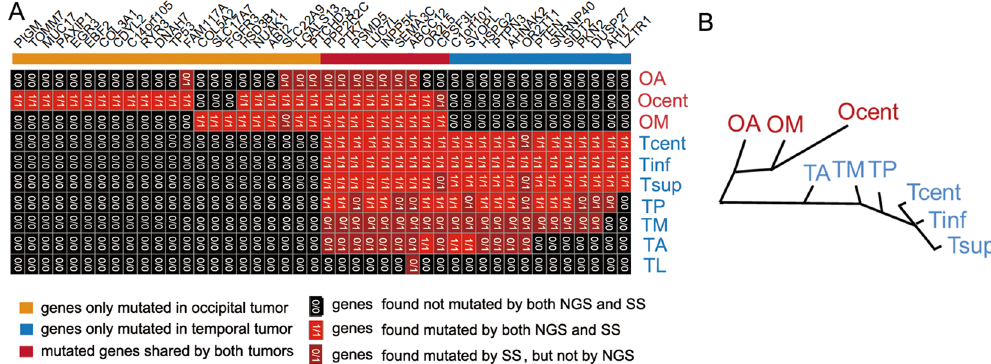
Figure 4. Genetic intra- and inter-tumor heterogeneity and phylogeny in Patient 1. ( A ) The regional distribution of 44 nonsynonymous point mutations in ten tumor samples. The heat map indicates the presence of a mutation (red/dark red) or its absence (black) in each region. The numbers in each cell indicate whether mutation presence was validated by NGS, Sanger sequencing (SS) or both. The color bars above the heat map indicate the classification of mutations according to whether they are unique or shared among regions. ( B ) shows phylogenetic relationships of the tumor regions; branch lengths are proportional to the number of nonsynonymous mutations separating the branching